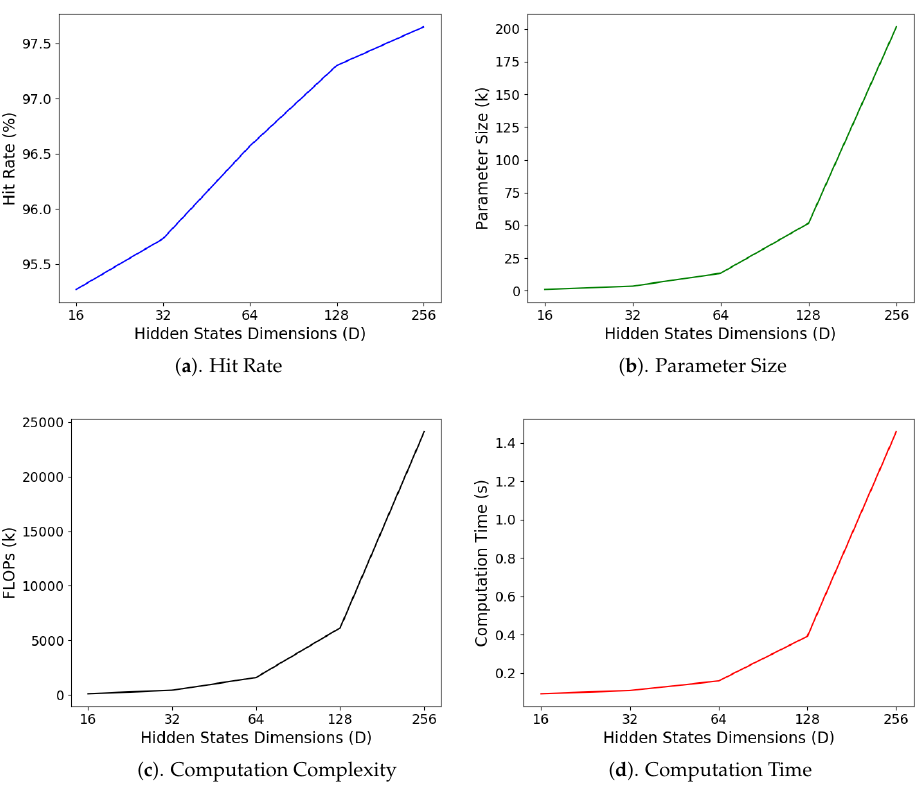
Figure 21. Average hit rate, parameter size, computation complexity, and average computation time of the GRU for different dimensions D of the hidden states. The average computation time is measured on the Raspberry Pi 3 platform. The window size of the experiments is T =